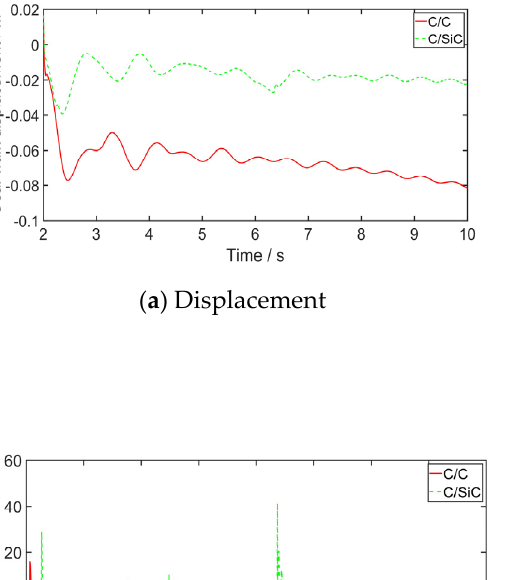
Figure 12. Brake disc materials’ effect on gear walk.